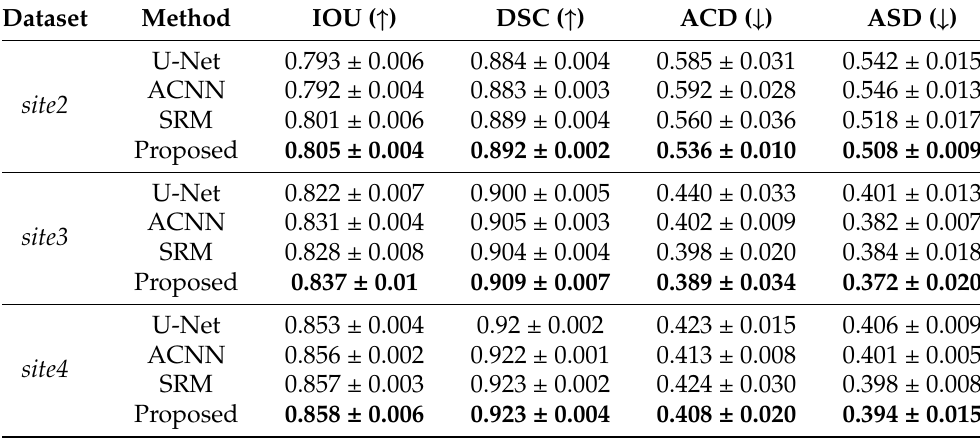
Table 5. Comparison of spinal cord segmentation test performance. The means and standard deviations over five runs are reported. For each dataset, the best result is shown in